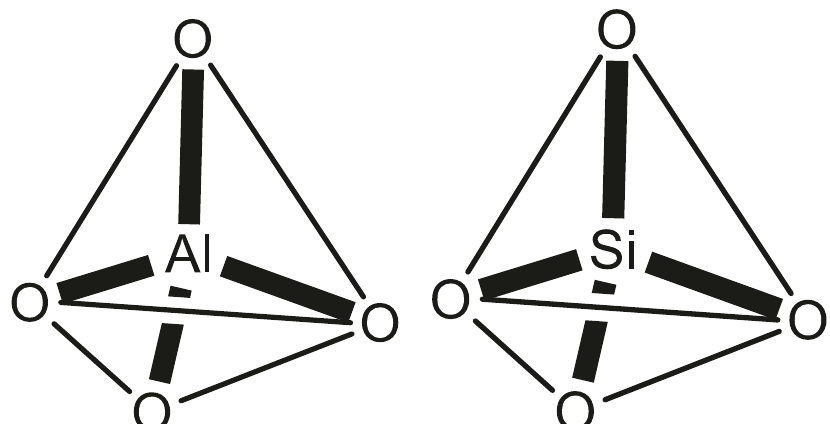
Figure 3: Sketch of the structure of the zeolite and [AlO